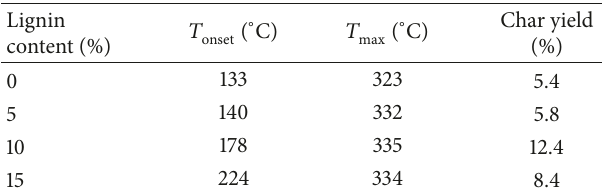
Table 2: Temperature and residue yield of the PU foams with different lignin